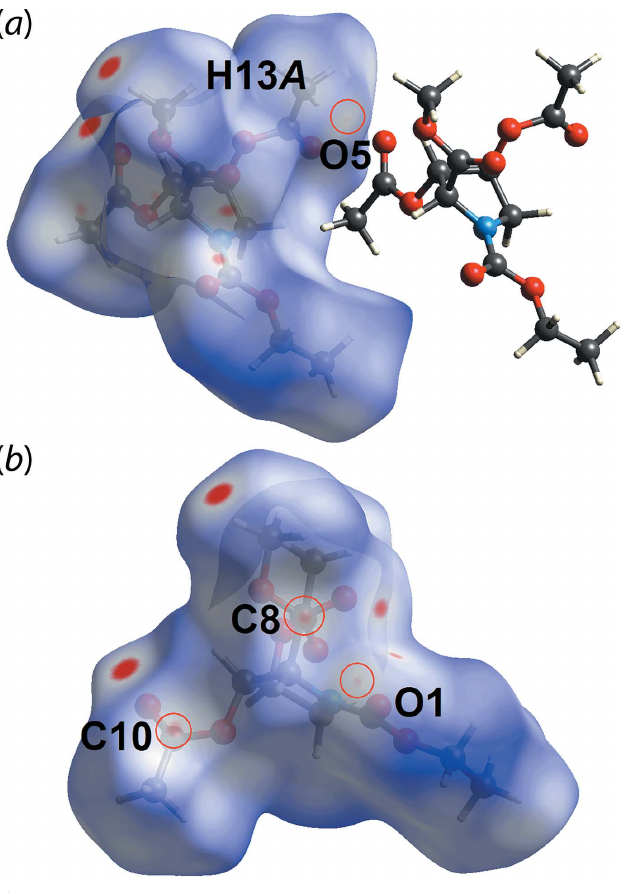
Table 1, a long C13—H13 A (cid:3) (cid:3) (cid:3) O5 interaction is reflected in the d surface as a faint red spot in Fig. 5( a ). In addition, short, norm